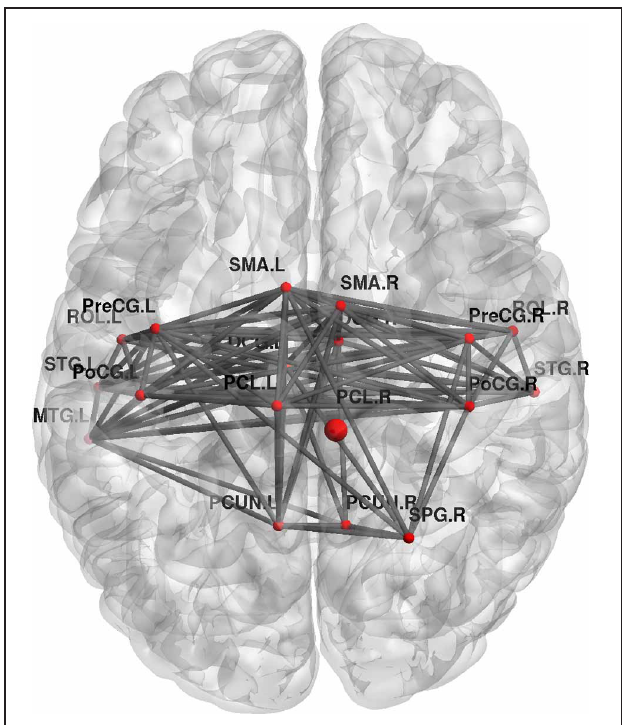
FIGURE 7 | Change in brain network graphs for regional local efficiency at a threshold of r = 0 . 6 following the explicit SRTT task. The highlighted regions represent significant nodes with more locally efficient communication in REST 2 compared with REST 1.